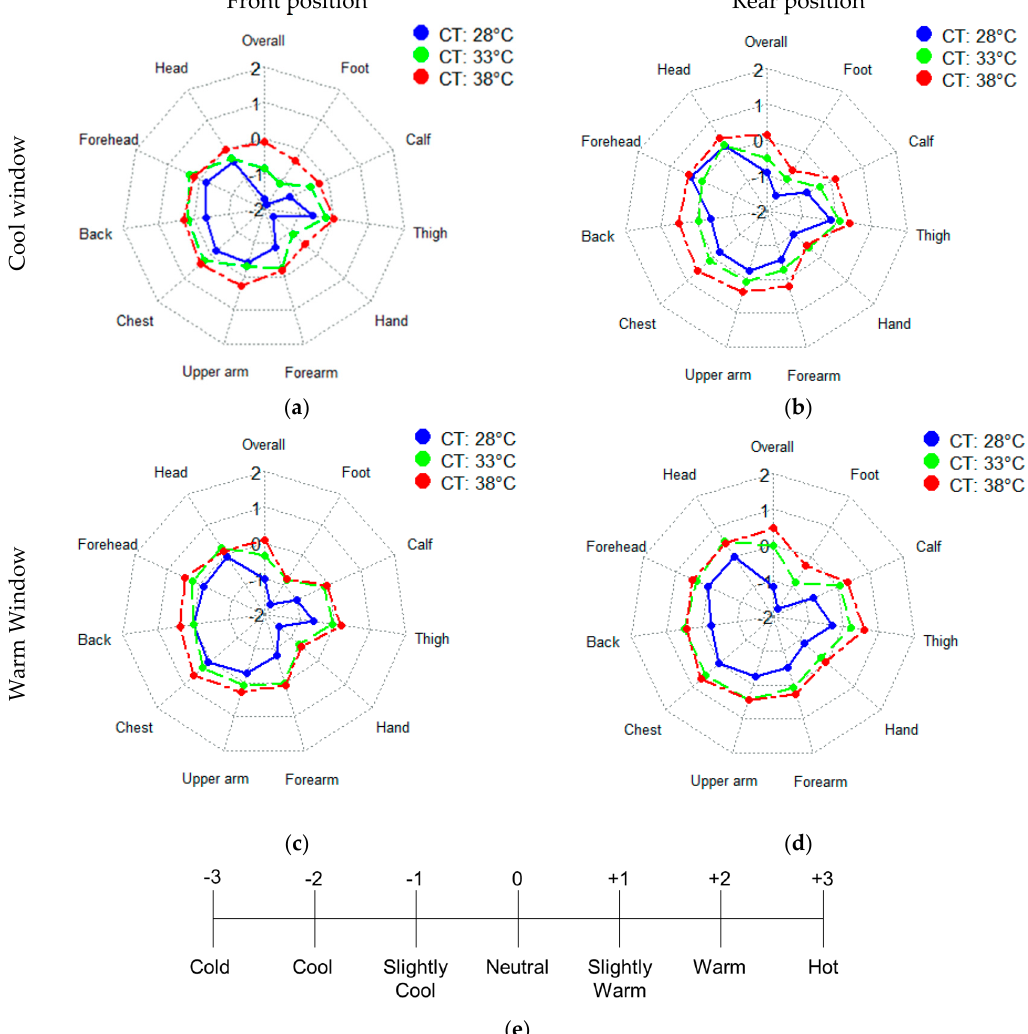
Figure 7. Average of overall/local thermal sensation votes in 12 different experimental scenarios. A combination of scenarios is presented in Figure 3 and Table 3. ( a ) Scenario group-1 related to the cool window and the front position; ( b ) Scenario group-2 related to the cool window and the rear position; ( c ) Scenario group-3 related to the cool window and the rear position; ( d ) Scenario group-4 related to the warm window and the rear position; ( e ) ASHRAE 7-point thermal sensation scale.